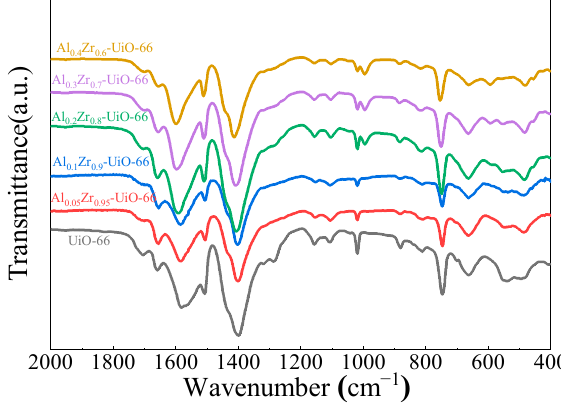
Figure 3. FTIR spectra of UiO-66 and Al-doped UiO-66 MOFs.